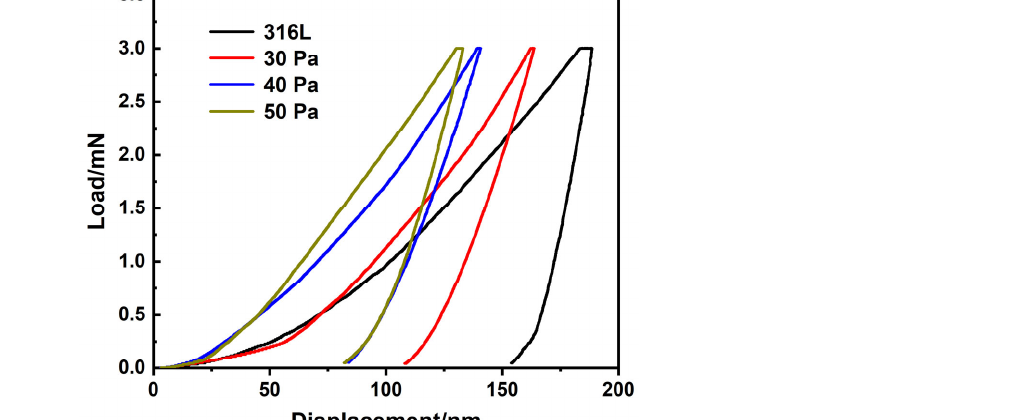
Figure 8. Variation curves of load versus displacement on the surface of alloying layers on 316L substrate and at 30 Pa, 40 Pa and 50 Pa of pressure. Table 3. Surface hardness of 316L substrate and alloying layers at 30 Pa, 40 Pa, and 50 Pa of pres ‐ sure. Sample Hardness/GPa